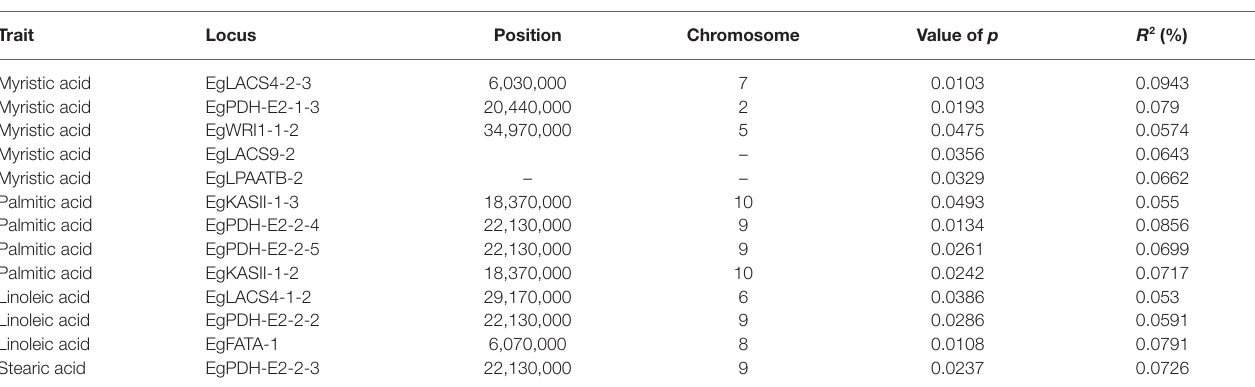
TABLE 4 | Association between IP markers and fatty acid components. Trait